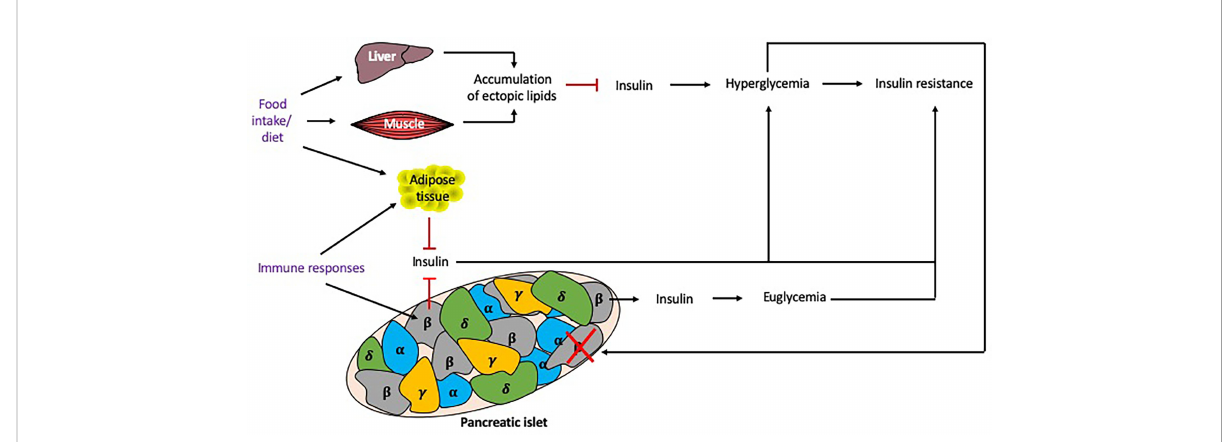
FIGURE 5 Factors in fl uencing insulin resistance. Multiple factors may contribute to the development of insulin resistance. Excess food intake and the type of diet eaten can promote the accumulation of lipids in tissues, reducing insulin signaling and causing hyperglycemia and insulin resistance. Chronic hyperglycemia induces b cell stress, leading to b cells that fail to secrete suf fi cient insulin to maintain euglycemia, or exhausted/ destroyed b cells, which do not secrete insulin, further promoting hyperglycemia. Genetics play an important role as some individuals may develop insulin resistance but remain euglycemic. Immune responses, particularly cytokines secreted from macrophages, can also promote adiposity and insulin resistance. Responses to food intake and immune responses (shown in purple) can be altered by the time of day and thus circadian rhythms may alter these responses. Black arrows indicate induction, red lines indicate